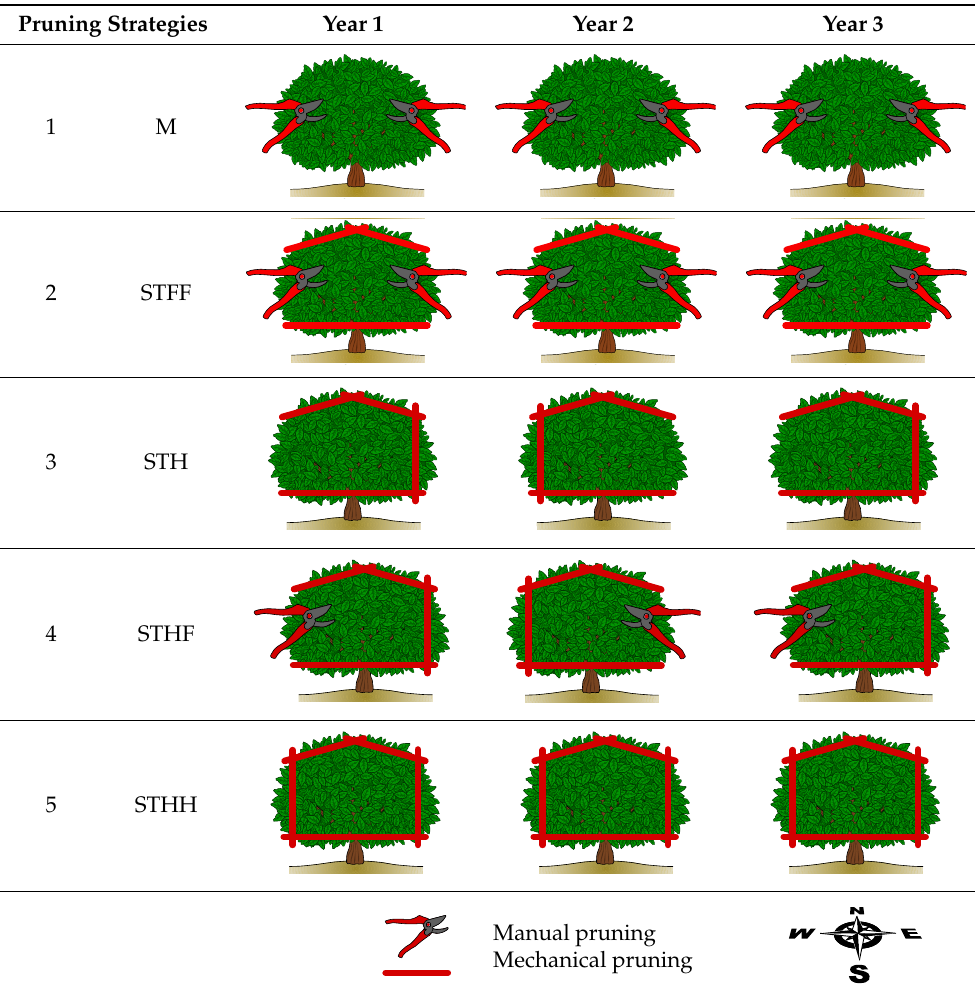
Table 1. Intervention sequences by pruning strategy.